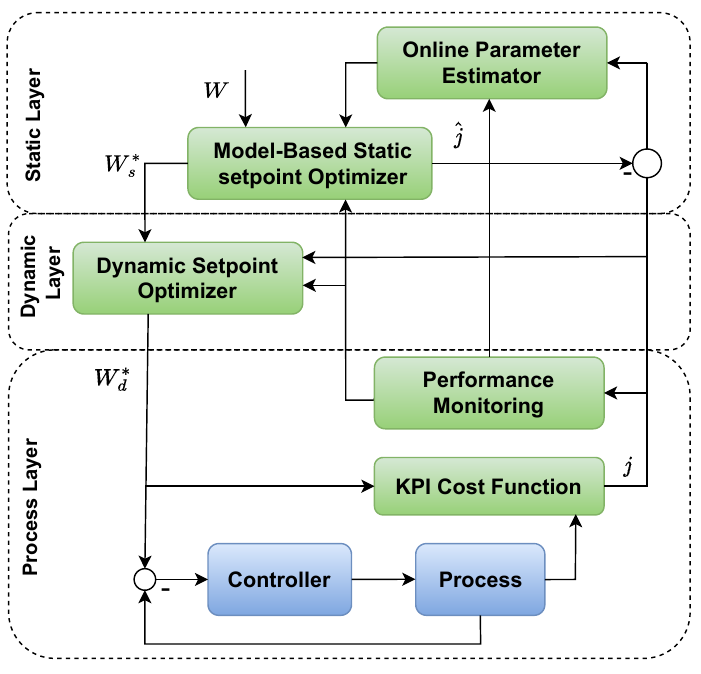
Figure 5. Diagram illustrating the proposed method in